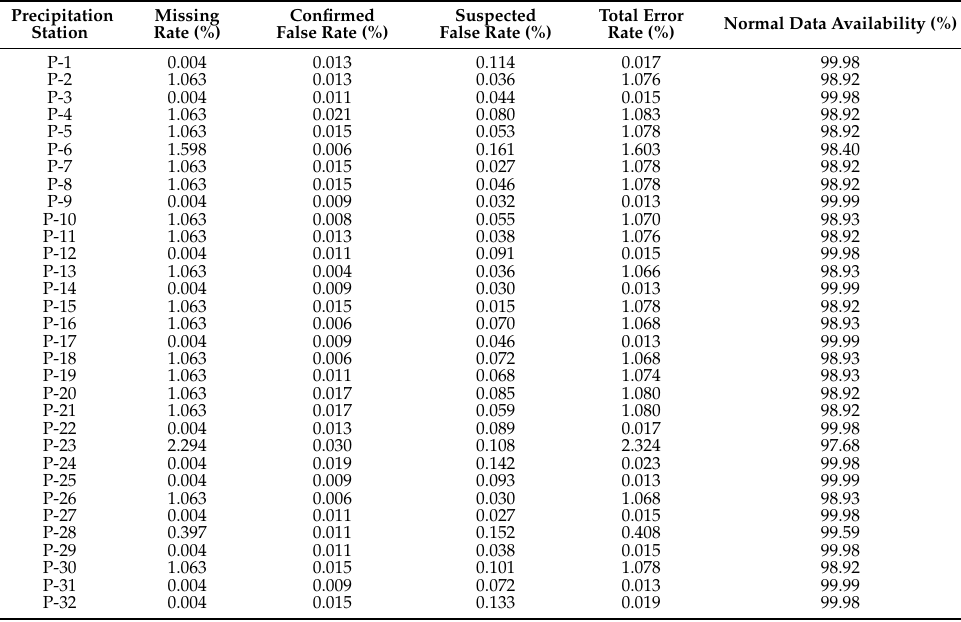
Table 6. Data availability analysis in 32 precipitation